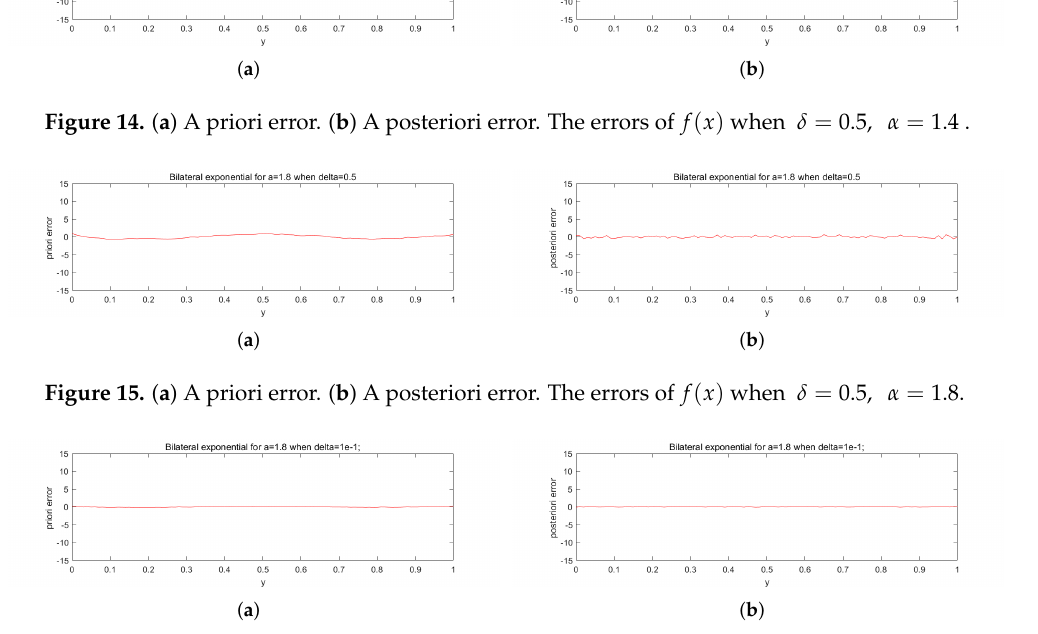
Figure 16. ( a ) A priori error. ( b ) A posteriori error. The errors of f ( x ) when δ = 1 × 10 − 1 , α =